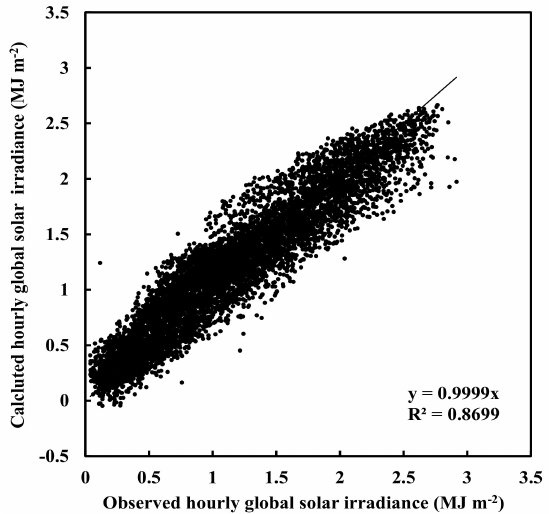
Figure 2. Scatter plot of calculated versus observed hourly global solar irradiance from 4:00 to 16:00 during April 2008–August 2011 under all sky conditions at Sodankylä (n = 7442).